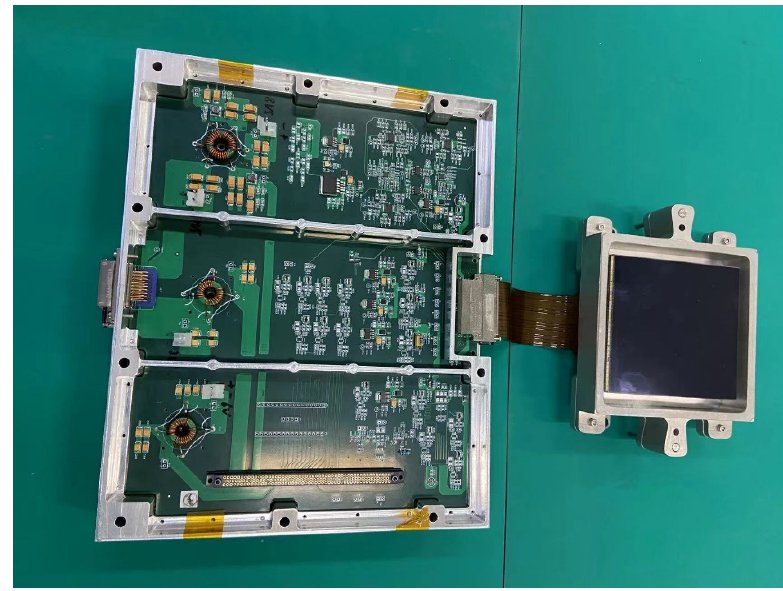
Figure 10. The space camera prototype.